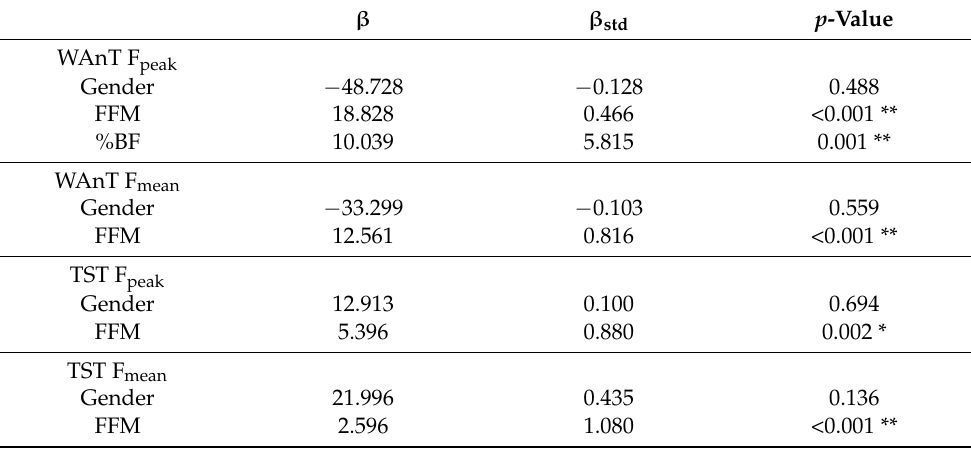
Table 3. The influence of gender and body composition on land and pool-based force